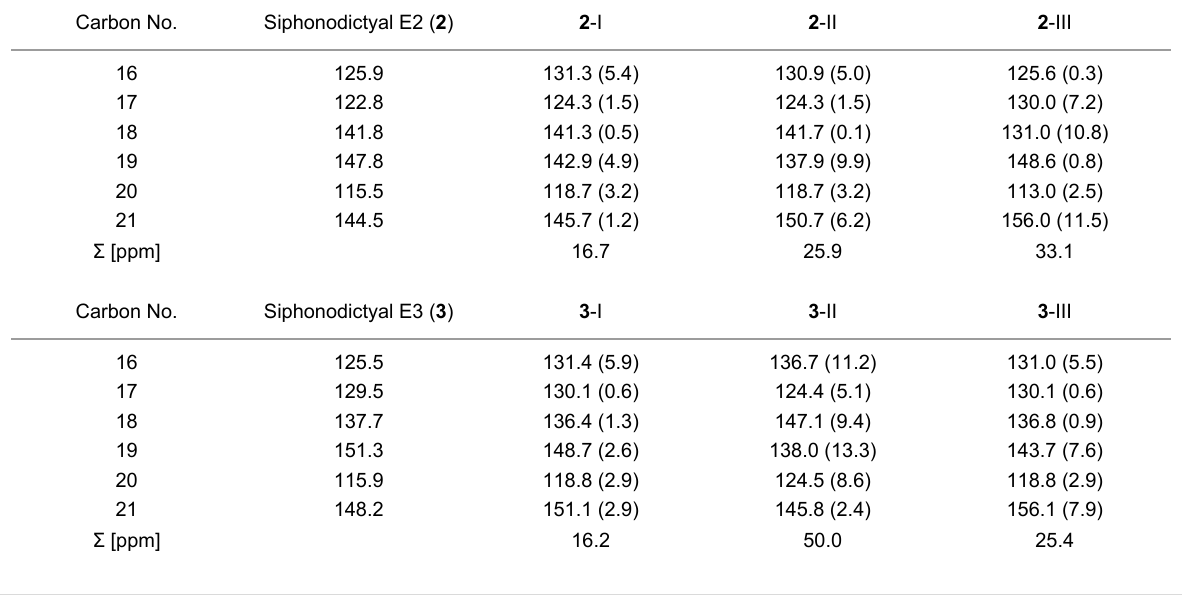
Table 3: Results of the increment calculations for the aromatic moiety of the three constitutional proposals of siphonodictyal E2 ( 2 ) and siphonod- ictyal E3 ( 3 ). Carbon